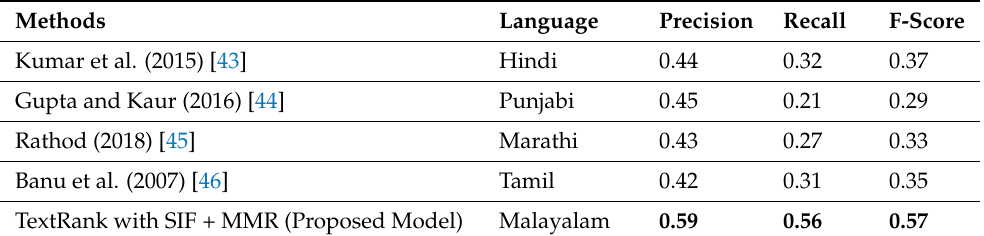
Table 7. Comparison with other researches in Indian